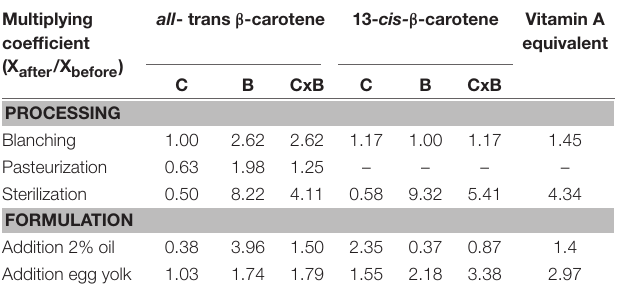
TABLE 3 | Impact of each processing and formulation step on concentration (C) and bioaccessibility (B) of the two main carotenoids of OFSP puree (home-made puree used as initial reference).